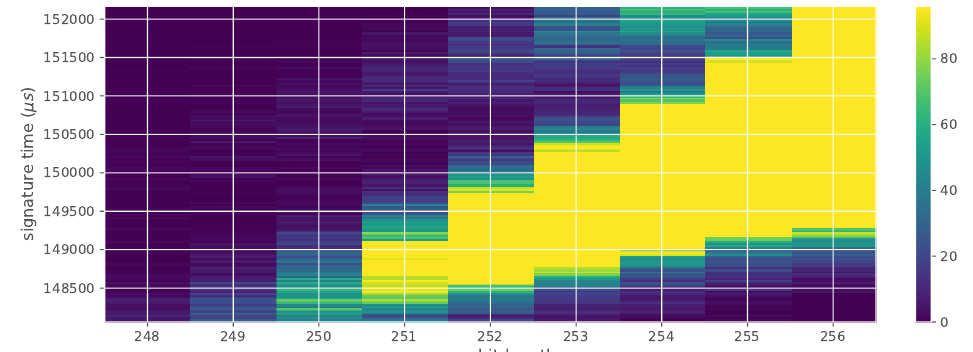
Figure 1: Heatmap of the signing duration and the bit-length of ECDSA nonces for 500 000 signatures using secp256r1 curve on the Athena IDProtect